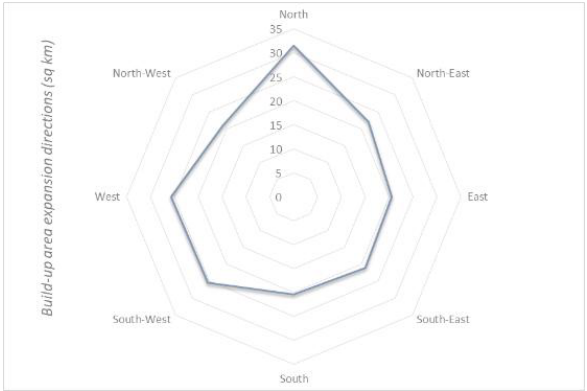
Figure 10 . Urban expansion of Bucharest between 1985 and 2015 by cardinal and ordinal directions. The graph illustrates the geospatial analysis within a 20 km radius buffer (data extracted from the WSF Evolution dataset created by DLR)